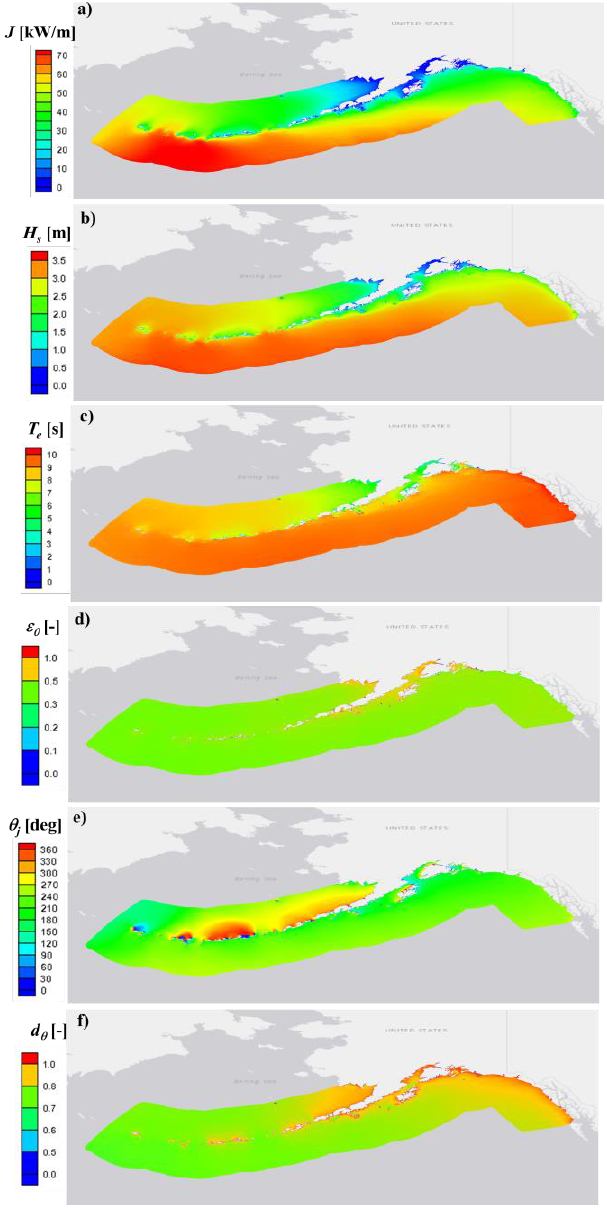
Fig. 10. Simulated annual averages of six IEC wave resource parameters for year 2009 in Alaska region: (a) omnidirectional wave power; (b) significant wave height; (c) energy period; (d) spectral width; (e) direction of maximum directionally resolved wave power, and (f) directionality